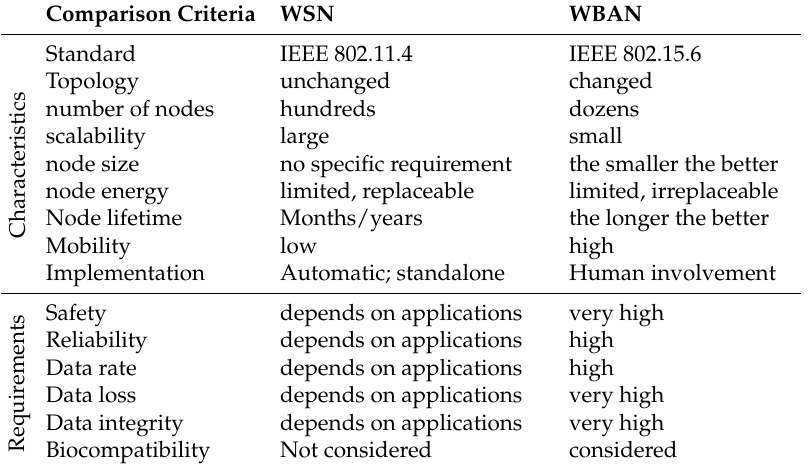
Table 1. Comparison of WSN and WBAN.